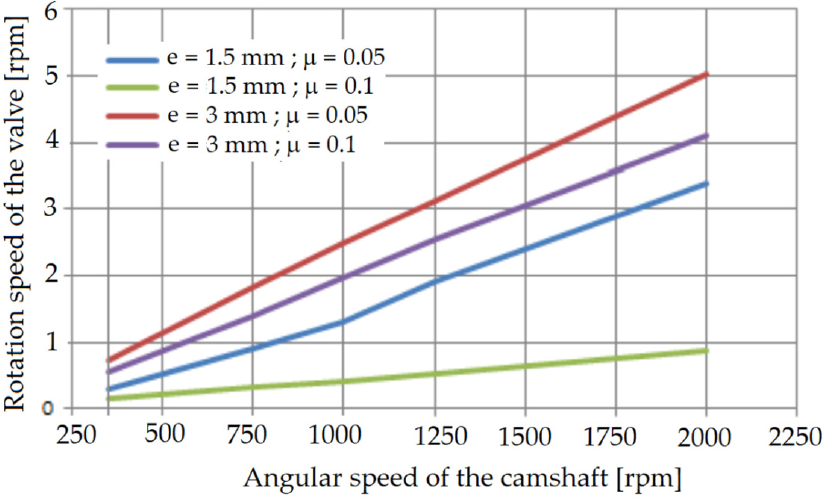
Figure 20. Variation of valve rotation speed depending on camshaft position.